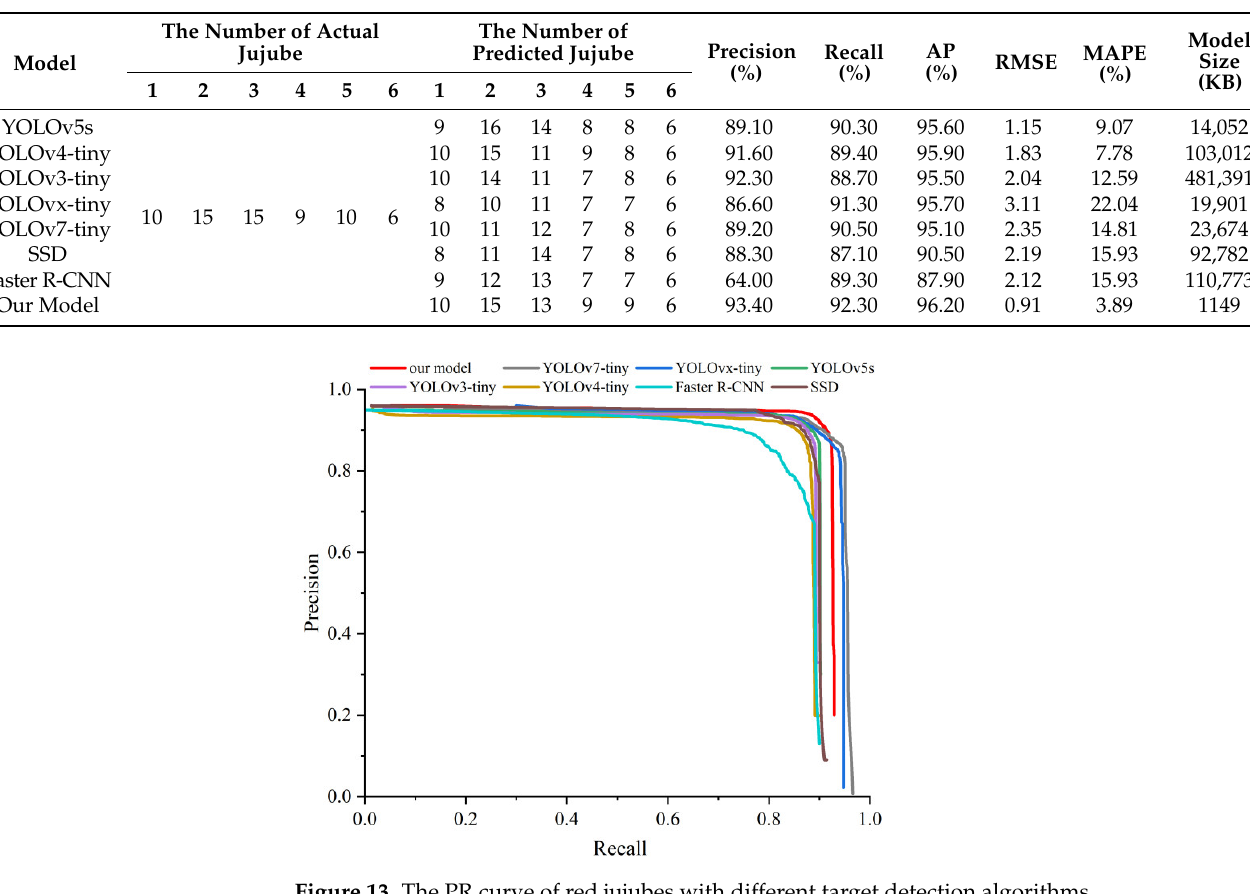
Figure 13. The PR curve of red jujubes with different target detection algorithms. The P-R curve is a curve with recall as the horizontal coordinate and precision as the vertical coordinate out of the curve, whose area can show the comprehensive performance of the target detection model for red jujubes. Figure 13. shows that the curve areas of YOLOv3-tiny, YOLOv4-tiny, YOLOv5s, YOLOvx-tiny and YOLOv7-tiny are larger than those of SSD and Faster R-CNN. It illustrates that the Yolo series detection networks have higher accuracy and better recognition of red jujubes. YOLOv5s is used as an improved detection network for YOLOv3-tiny and YOLOv4-tiny, but the best detection result is not obtained for red jujubes, as shown in Table 5. The YOLOv4-tiny has better detection re- sults, but the YOLOv5s are smaller in model size and more suitable for being used in agricultural mobile devices. Compared with the classical networks, the improved network not only maintains a better detection performance but also greatly reduces the model size.